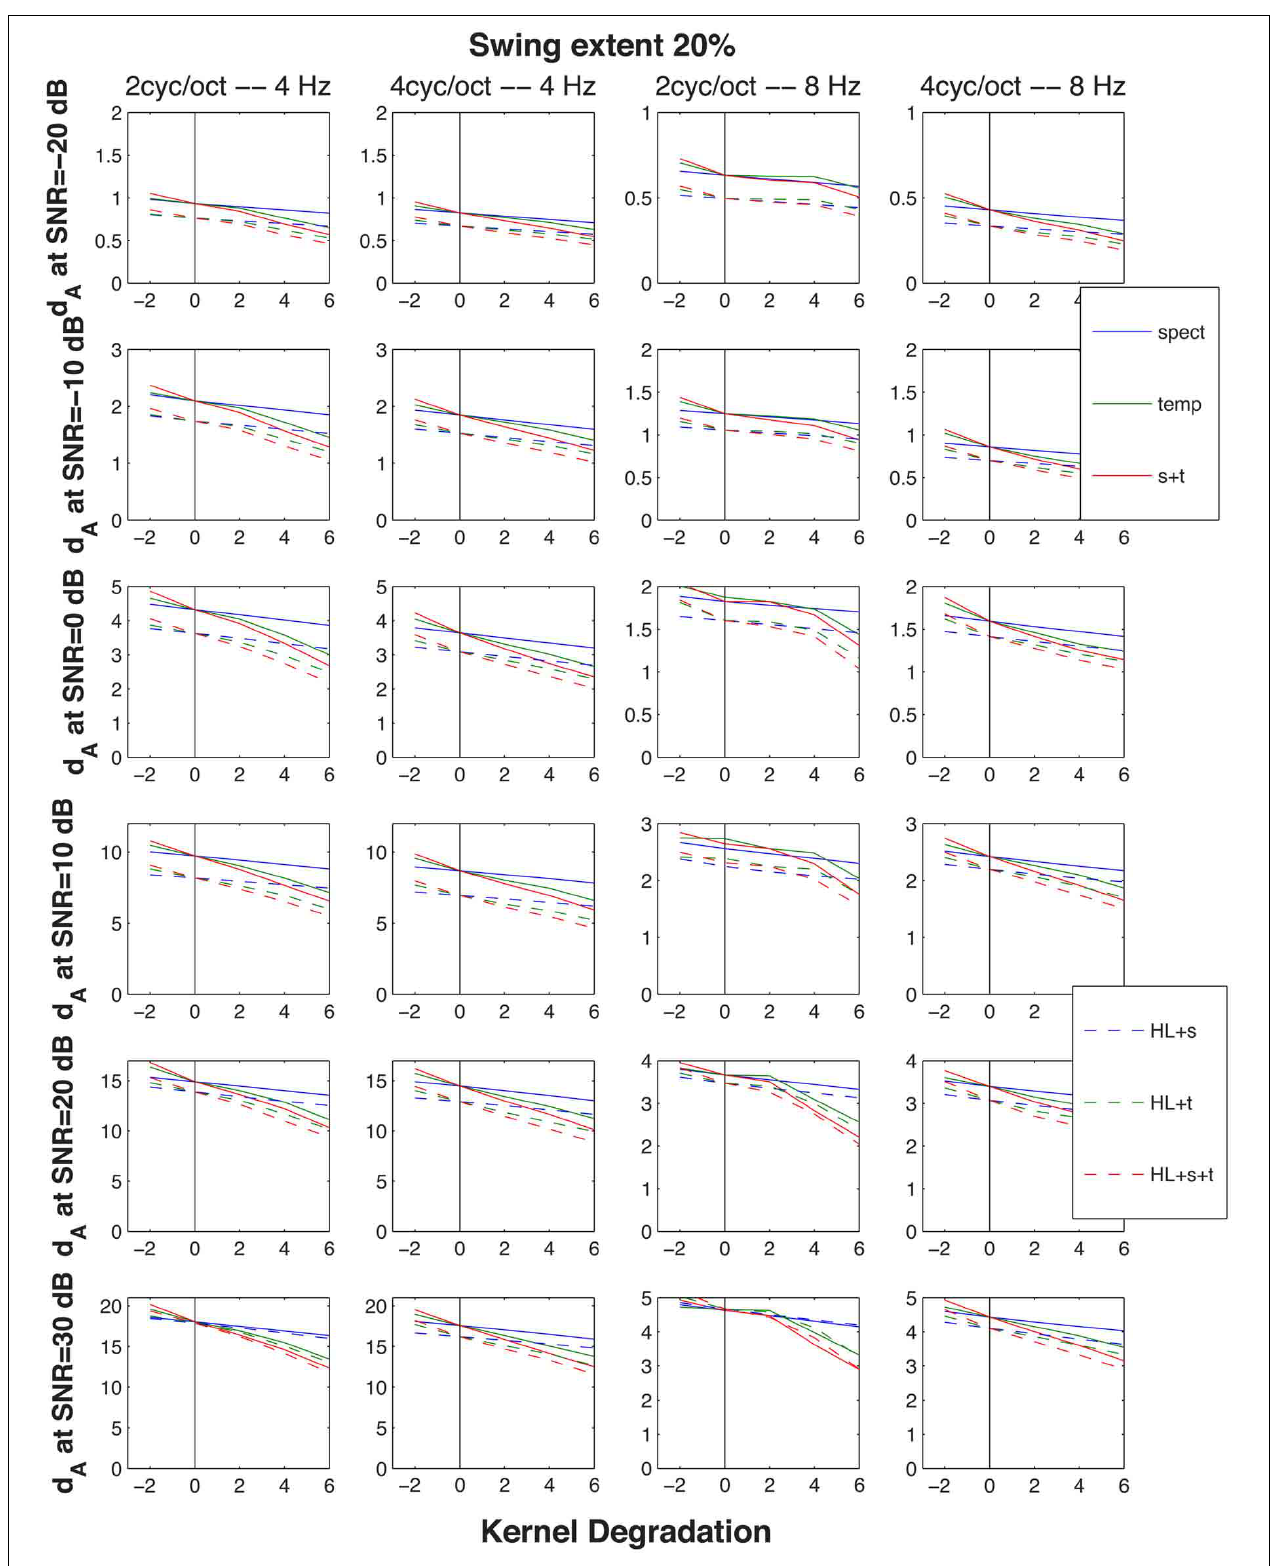
FIGURE 6 | Cumulative normalized Euclidean distances d A between STRF patterns generated by the up-down and the down-up targets presented in an identical (magnitude and phase) distracter and identical